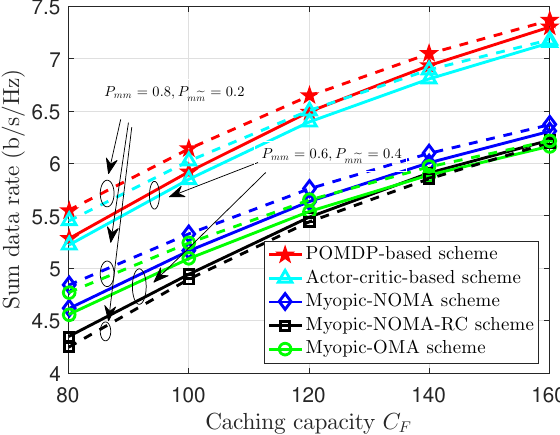
Figure 10. The sum data rate with respect to caching capacity.